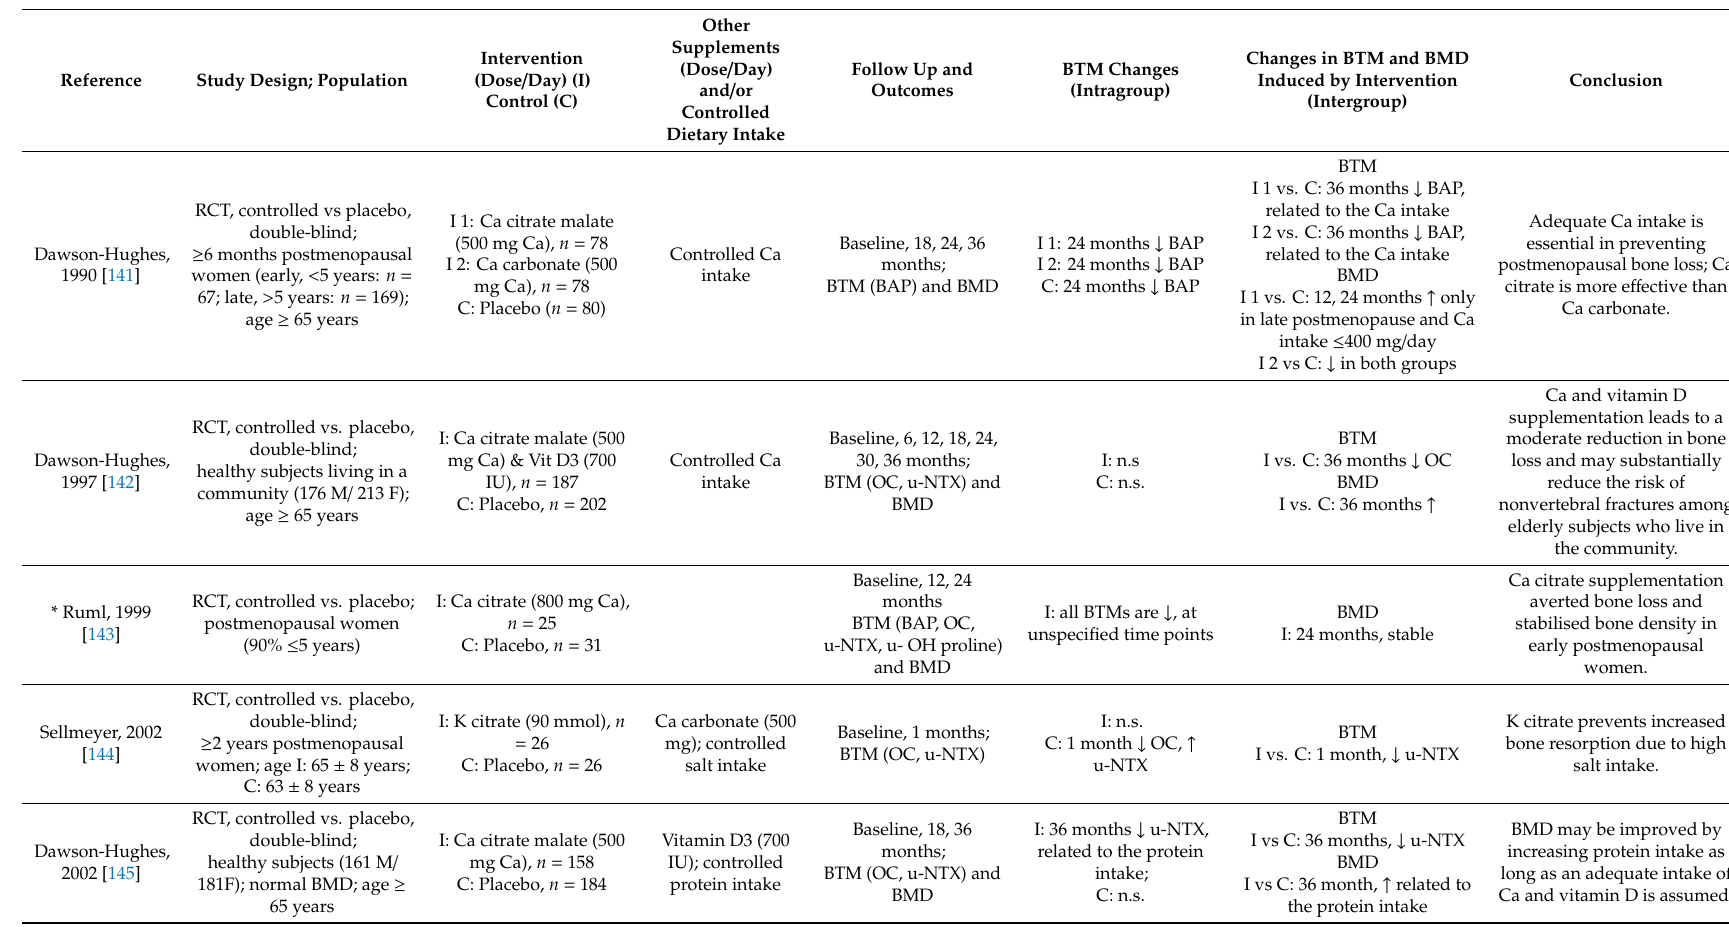
Table 3. Interventional clinical trials based on the use of citrate supplements with primary or secondary outcomes related to bone health status.